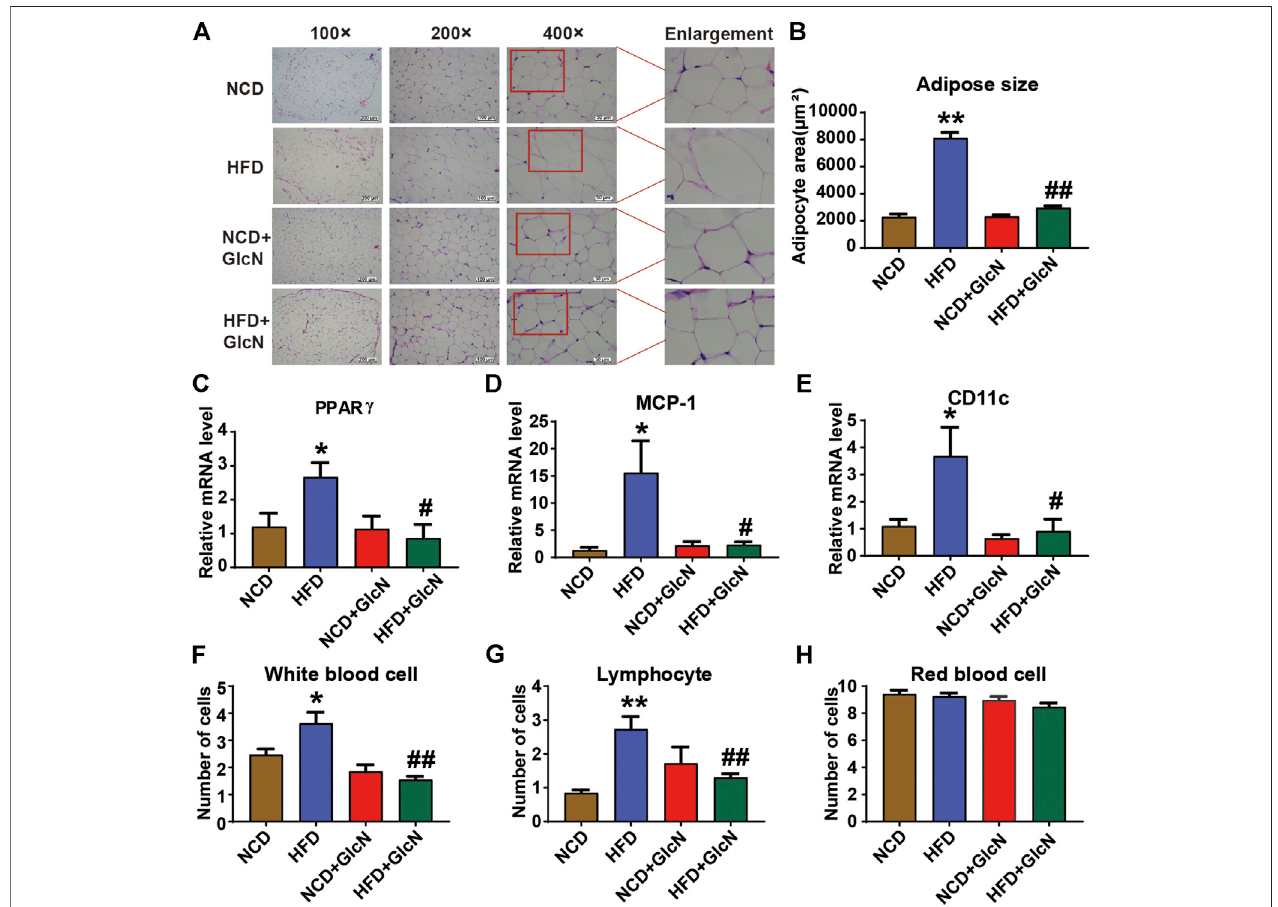
FIGURE 8 | GlcN inhibited in fl ammatory responses in white adipose tissues (WATs) and blood of HFD-fed mice. After the treatment with NCD, HFD, and/or GlcN (1 mg/ml, in drinking water) for 5 months, all mice were sacri fi ced. WATs were morphologically observed by H&E staining (A) and the size of adipocytes was statistically analyzed (B) . The mRNA levels of pro-in fl ammatory and adipose differentiation-related cytokines were determined by RT-PCR, including PPAR γ (C) , MCP-1 (D) , and CD11c (E) . The number of white blood cells (F) , lymphocytes (G) , and red blood cells (H) in the blood of each experimental group were also measured. Data were shownasmeans ± SEM( n (cid:1) 5).* p < 0.05,** p < 0.01indicatesthedifferencebetweenHFDgroupandNCDgroup; # p < 0.05, ## p < 0.01indicatesthedifferencebetween HFD + GlcN group and HFD